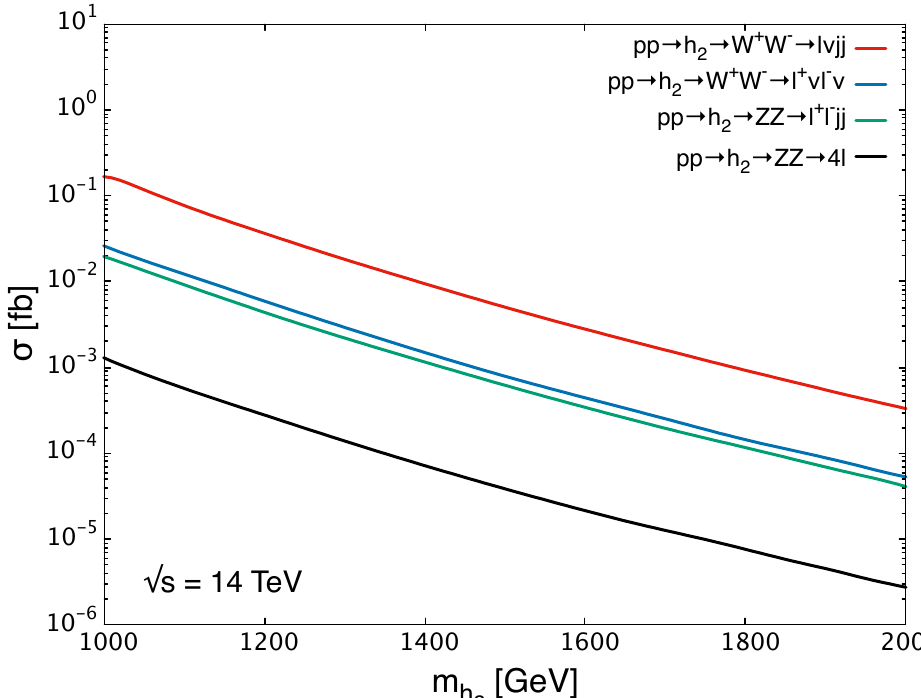
Figure 5. Effects of the heavy DS scalar H (cid:48) on the production of jets and leptons. The cross sections fall with the H (cid:48) mass in accordance with the naturalness bound in (43). In general, the heavier the naturally coupled dark sectors, the larger the luminosity needed to detect them. The negative searches at the LHC may be a result of the naturally coupled nature of the dark sector scalars. (taken from Reference [39], with the permission of the